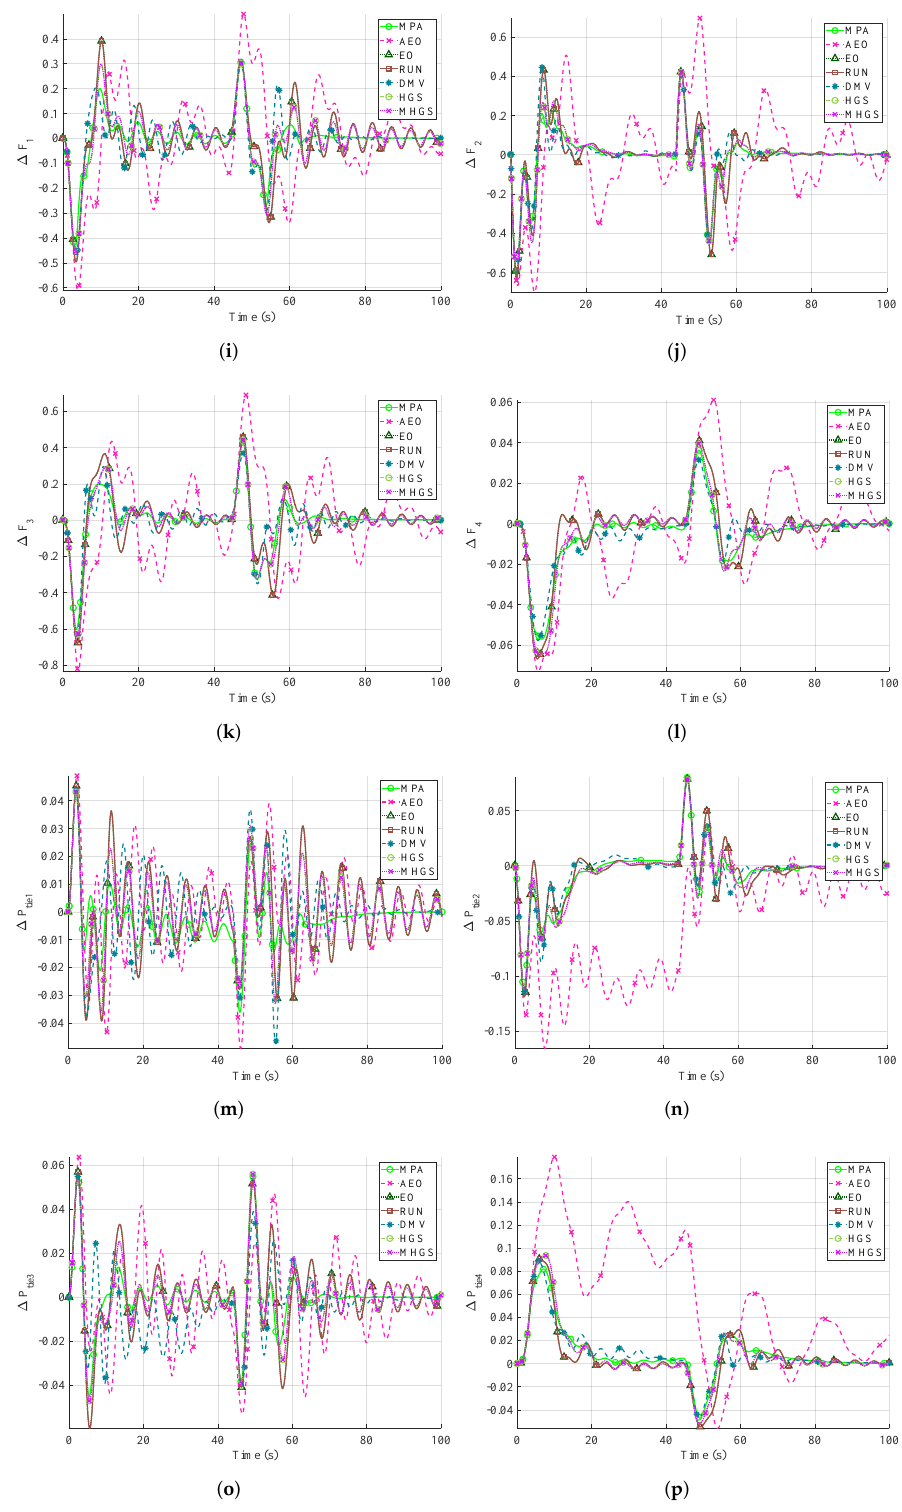
Figure 17. Time responses of variable load disturbance applied on area 2 of multi-interconnected area for: ( a ) ∆ f 1 , ( b ) ∆ f 2 , ( c ) ∆ f 3 , ( d ) ∆ f 4 , ( e ) ∆ P tie 1 , ( f ) ∆ P tie 2 , ( g ) ∆ P tie 3 , and ( h ) ∆ P tie 4